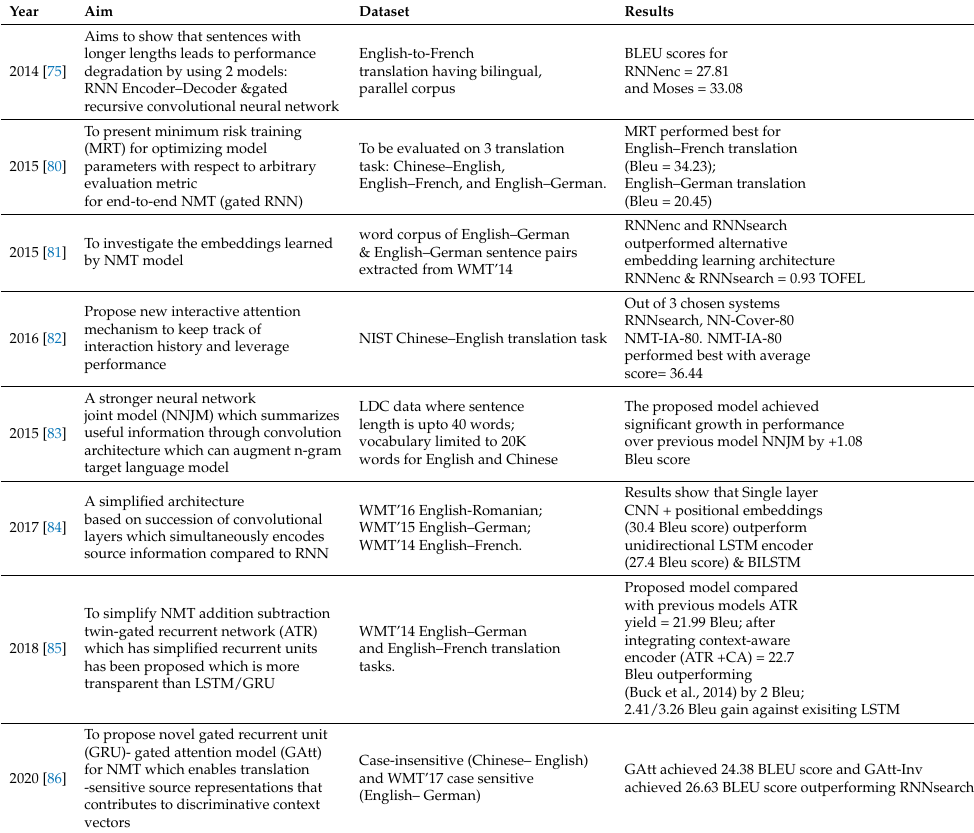
Table 5. Survey for neural machine translation